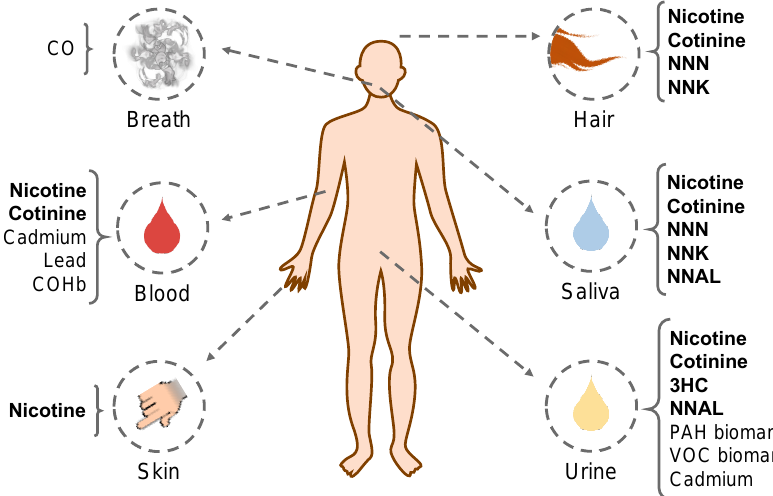
Figure 1. Summary of the biological matrices studied in this review and the tobacco smoke biomarkers determined in each matrix. Tobacco specific biomarkers are indicated in bold. CO: carbon monoxide; NNN: N′-nitrosonornicotine; NNK: 4-(methylnitrosoamino)-1-(3-pyridyl)-1-butanone; COHb: Carboxyhemoglobin; 3HC: trans -3’-hydroxycotinine; NNAL: 4-(methylnitrosamino)-1-(3-pyridyl)-1-butanol; PAH: polycyclic aromatic hydrocarbon; VOC: volatile organic compounds.